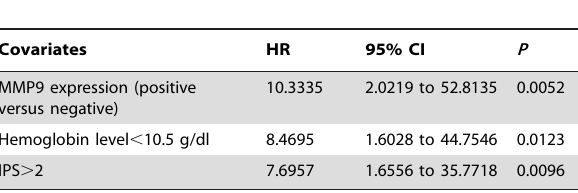
Table 3. Multivariate Cox Regression Analysis for Overall Survival of patients with classical Hodgkin lymphoma between 15 and 45 years of age (n=